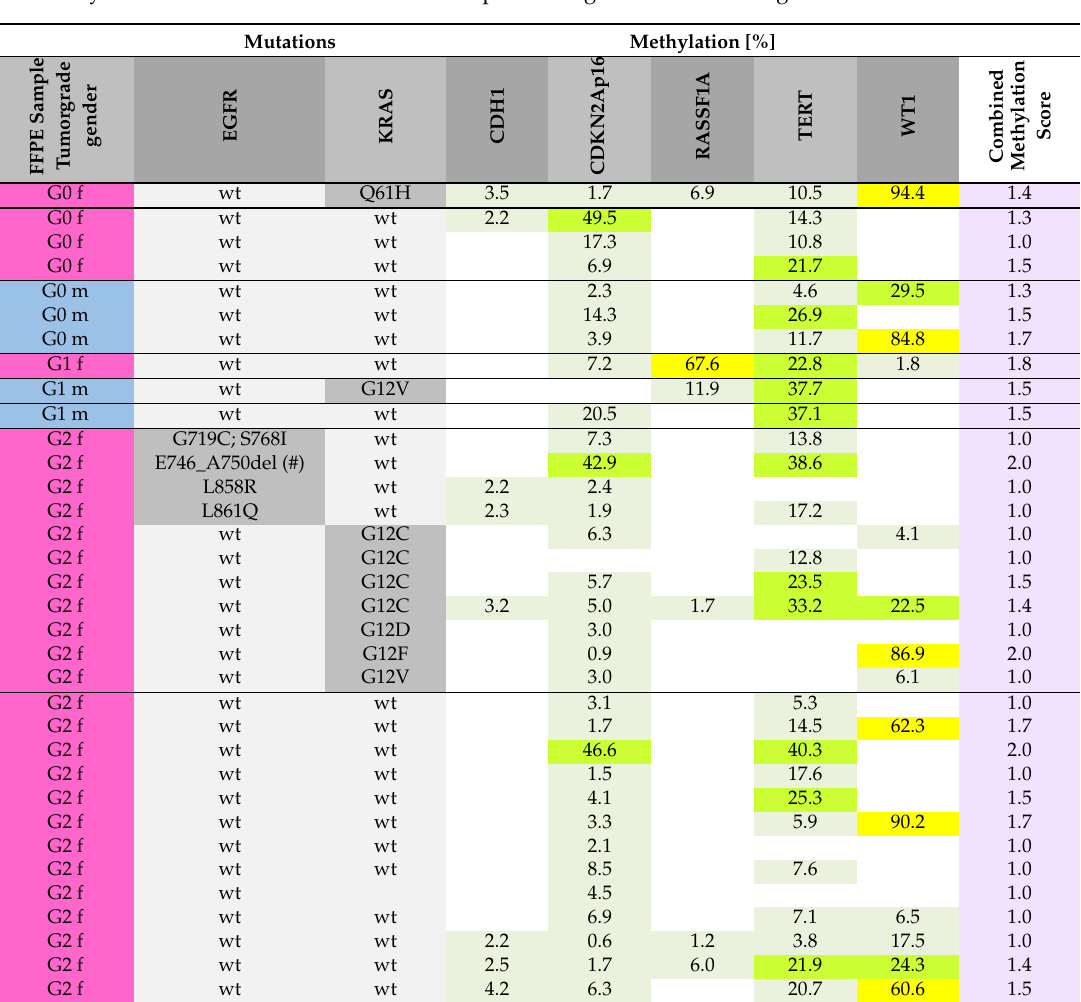
Table 1. Methylation patterns of formalin-fixed para ffi n-embedded (FFPE) samples along with KRAS and epidermal growth factor receptor (EGFR) mutational status, gender, and tumor grade; mutated EGFR and KRAS are indicated by darker grey shadowing, pink and blue represent patient gender as female or male, respectively; as for the methylation levels of CDH1, CDKN2Ap16, RASSF1A, TERT, and WT1, the shown values are average methylation scores (%) over the analyzed CpG-island (CGI) in at least 3 technical replicates. Light green indicates low methylation ( < 21%), bright yellow indicates strong methylation ( > 59%), and median methylation is represented by a yellow-green color. Blank positions are missing data, as not all analyses were successful in 3 replications on limited sample volumes. A combined methylation score was calculated summing the ordinal methylation levels, for which “low” methylation counts for 1, “med” for 2, and “high” methylation for 3; considering missing values, the methylation score was divided by 5, ranging from 0 to 3, it allows a very rough interpretation of data trends, where di ff erences only occur in high-grade tumors, where the average methylation scores of male and mutated samples are higher than the average.